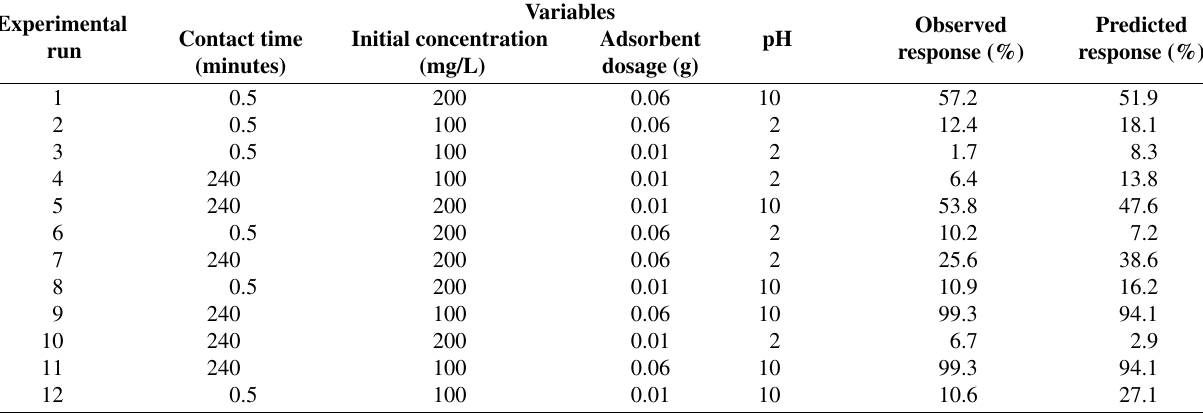
Table 5. Plackett-Burman design and results for the removal of MB by